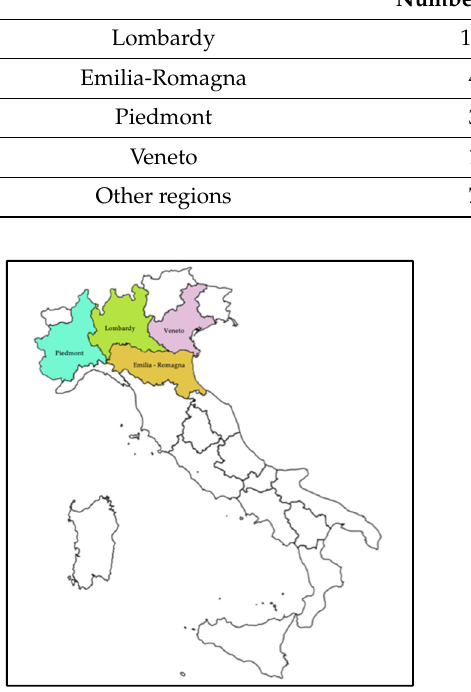
Table 2. Geographical areas with the highest percentages of deaths due to COVID-19. The percentage is calculated in relation to the total number of deceased in Italy (33,340).